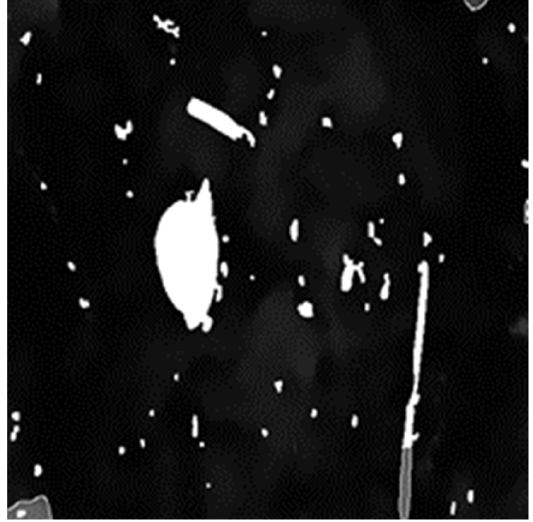
Figure 11. Hole filling.